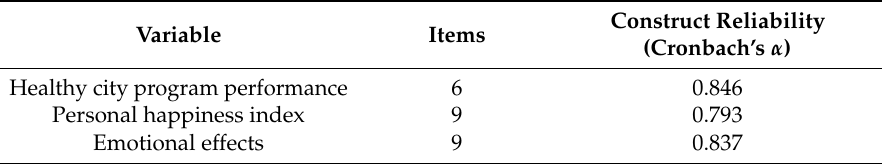
Table 3. Reliability